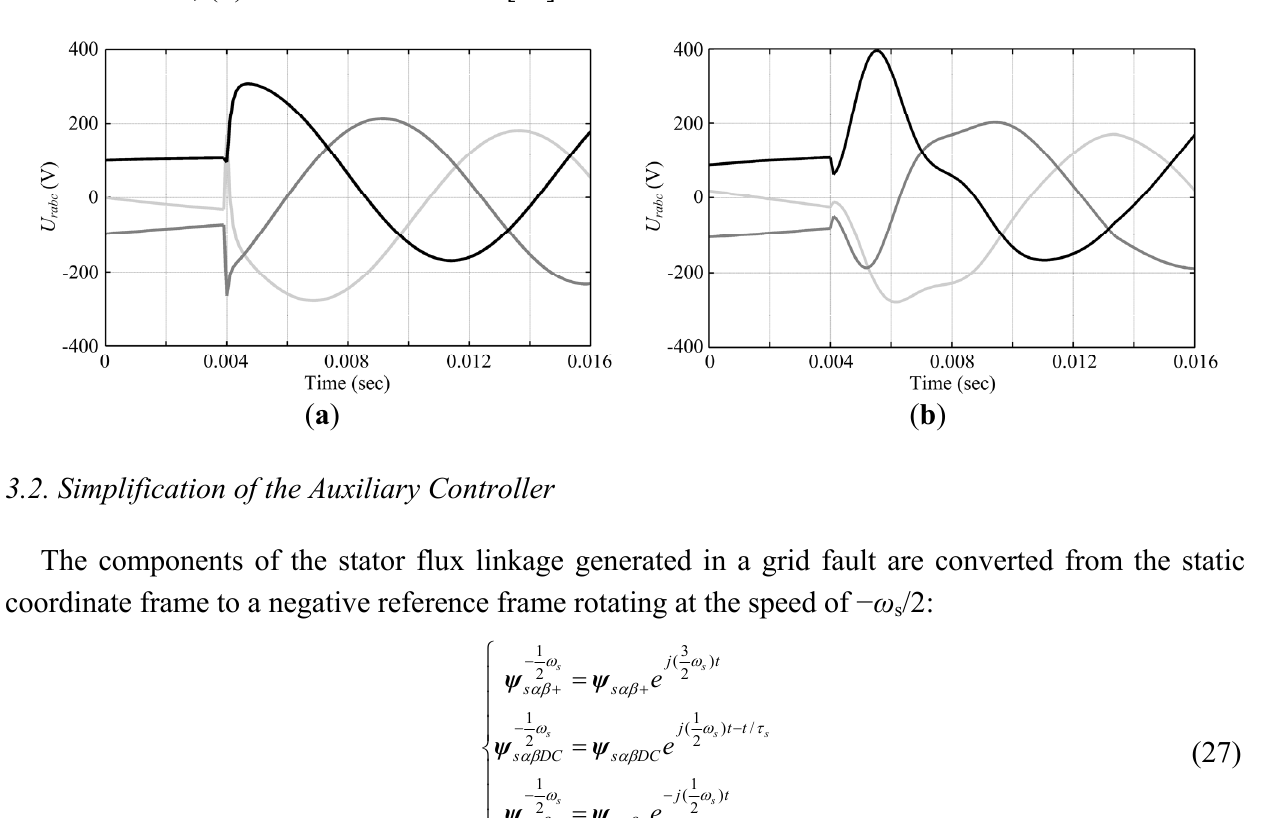
Figure 8. Controller output voltage during voltage drop. ( a ) Proposed PR current controller; ( b ) Current controller in